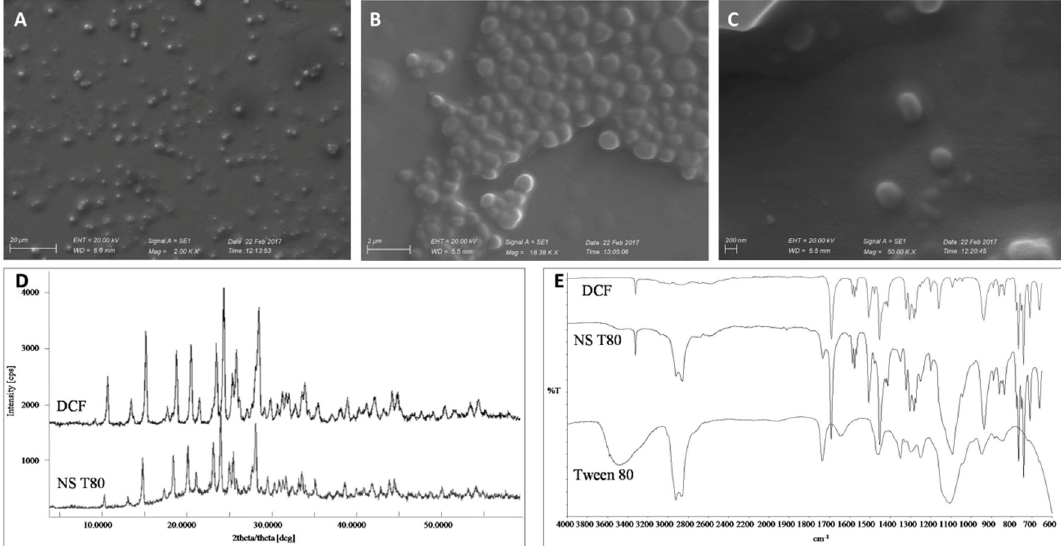
Figure 1. Characterization of NS T80 diclofenac (DCF) nanosuspensions. ( A – C ) Scanning electron microscopy images, scalebars 20 µm, 2 µm and 200 nm, respectively. ( D ) X-ray powder diffraction of bulk DCF and DCF nanosuspensions. ( E ) Fourier transform infrared spectroscopy of bulk DCF, DCF nanosuspensions and Tween 80.